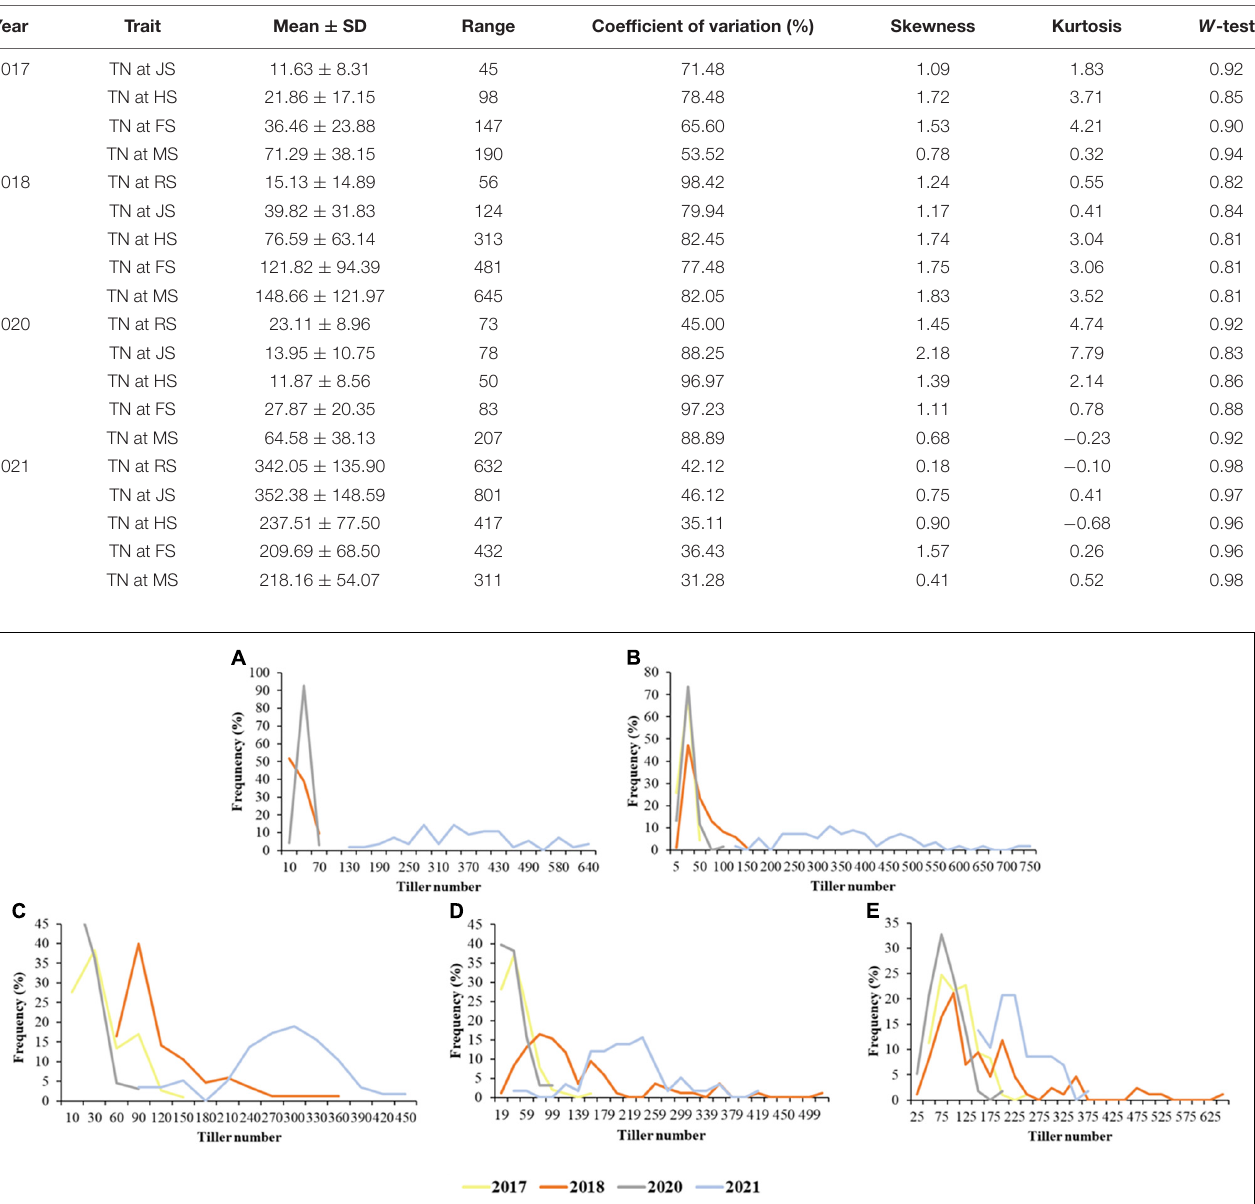
TABLE 1 | Tiller number (TN) of F 1 population at different stages in A. Gaertn. under 4 years.